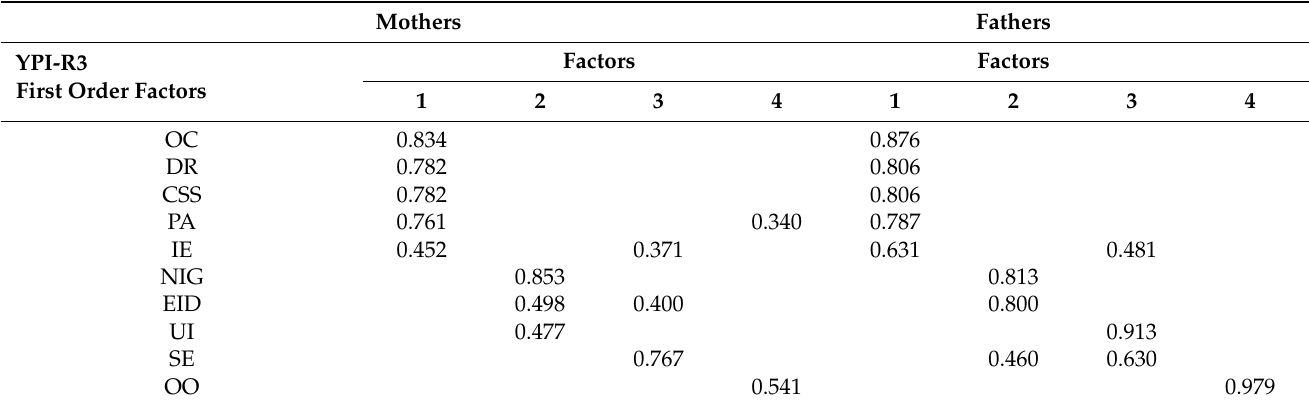
Table 2. Four-Factor Solution for YPI-R3 using Singapore Mothers and Fathers Sample.